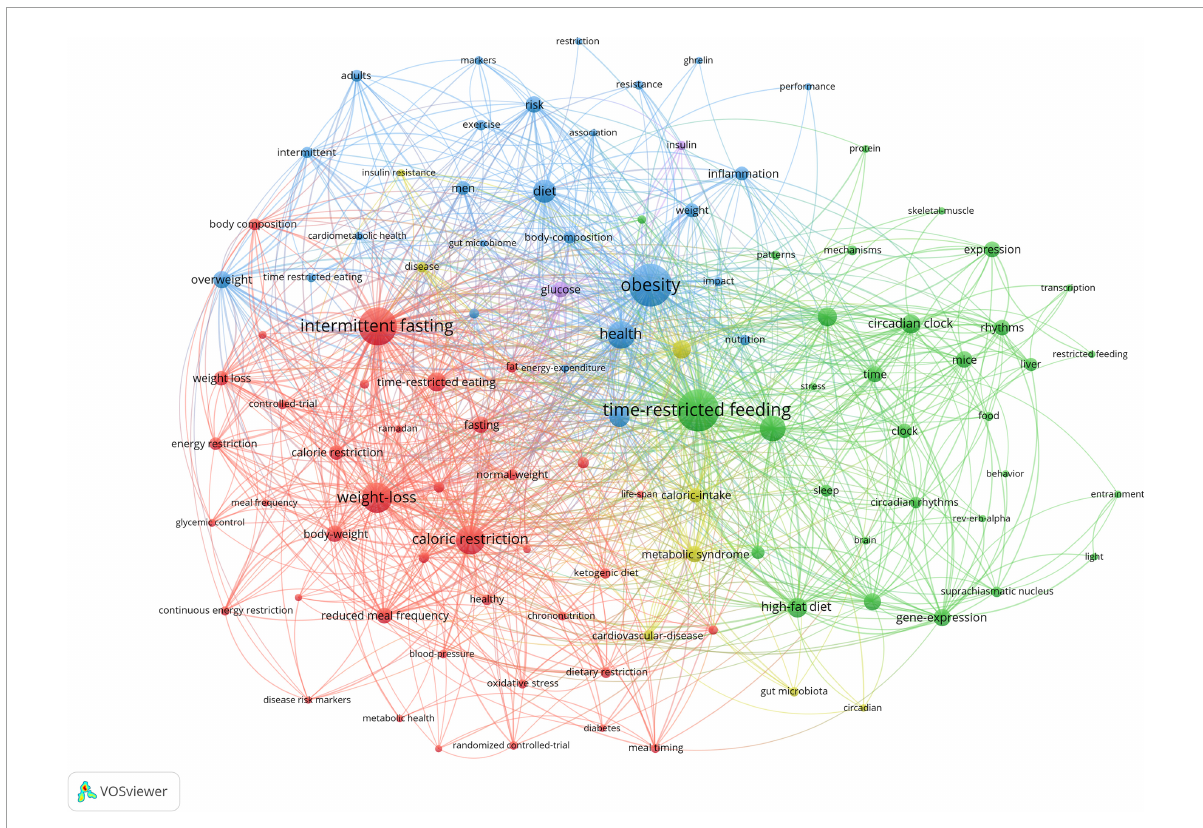
FIGURE5 Visualization of keyword co-occurrence analysis. The size of nodes indicates the frequency of occurrences of the keywords. The lines between the nodes represents their co-occurrence in the same publication. The shorter the distance between two nodes, the larger the number of co-occurrence of the two